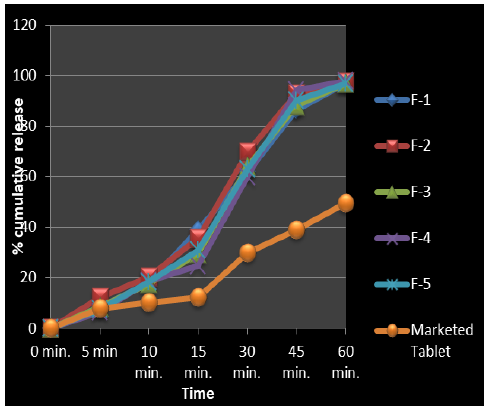
Figure 5. Comparative dissolution profile for formulas (F-1 to F-5) and marketed tablet of CC. in 0.1N HCl (pH 1.2) with 0.5 % tween 20 at 37